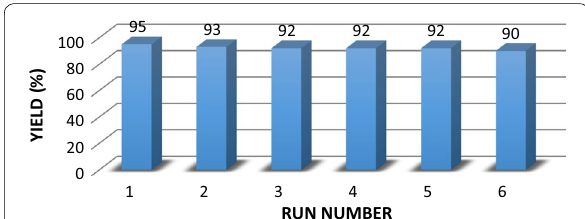
Fig. 5 Reusability of Fe 3 O 4 @CM in the synthesis of pyrimidinones ( 4a